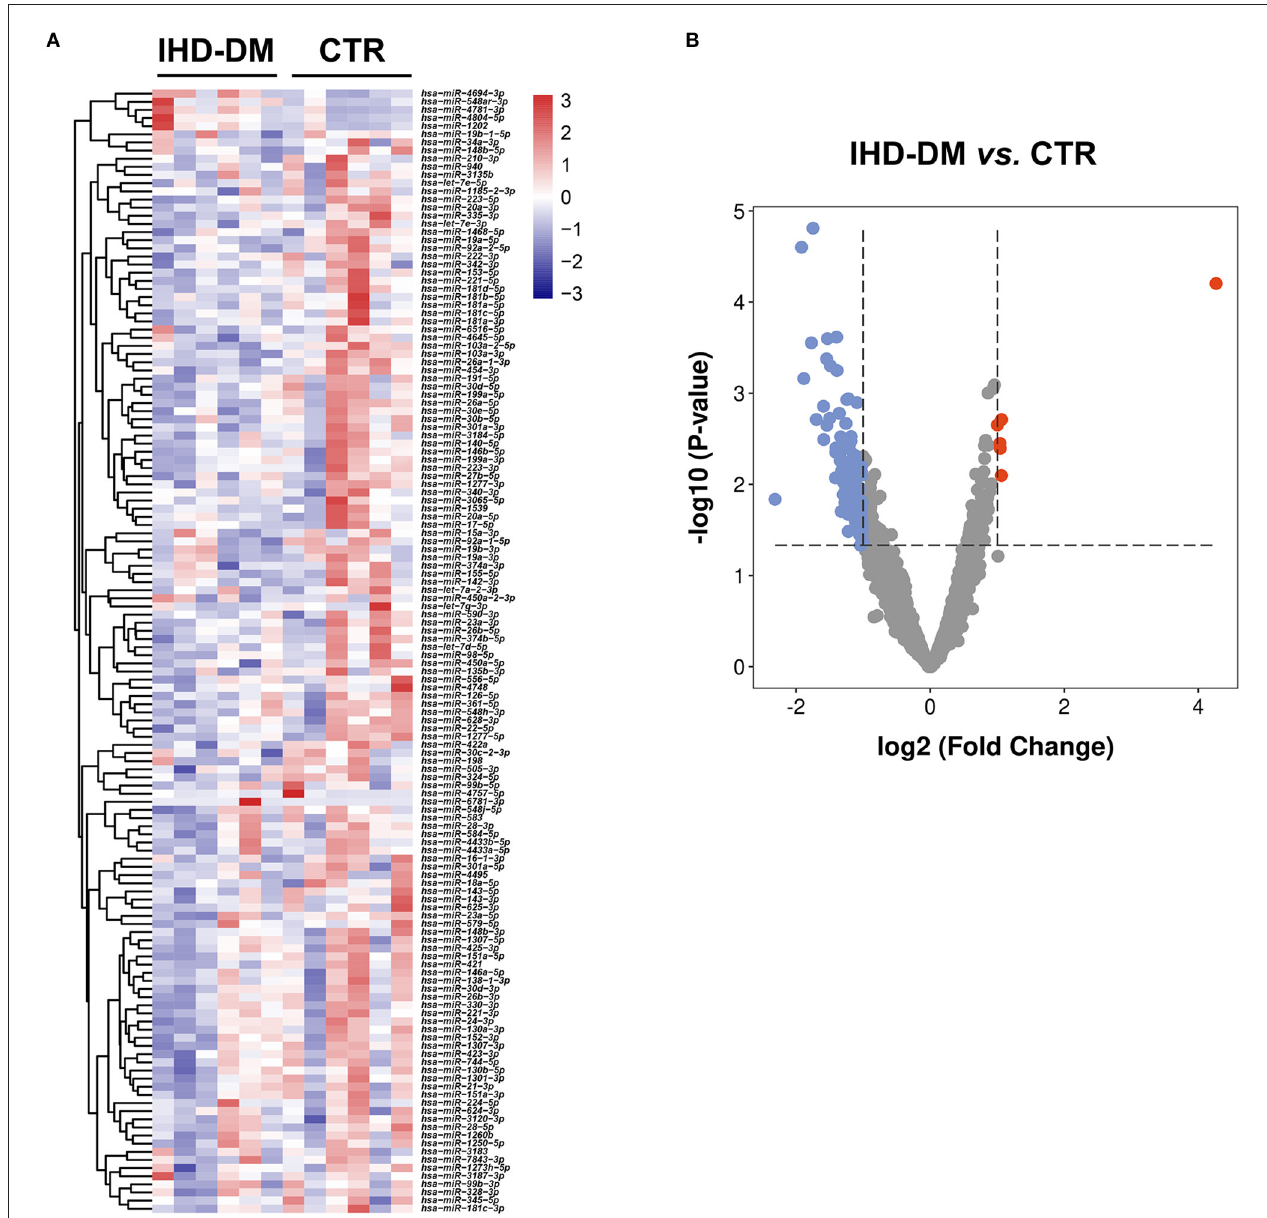
FIGURE 2 | Cluster analysis of differentially expressed EV-carried miRNAs between IHD-DM and healthy controls. (A) Heatmap of differentially expressed EV-carried miRNAs between IHD-DM patients and healthy controls. (B) Volcano plots of EV-carried miRNAs expression levels in plasma of IHD-DM and healthy controls. x - and y -axes show estimated expression difference measured in log 2 (fold change) and the significance of the expression difference measured in -log 10 ( P -value), respectively. Vertical lines referred to a two-fold difference in expression between the two